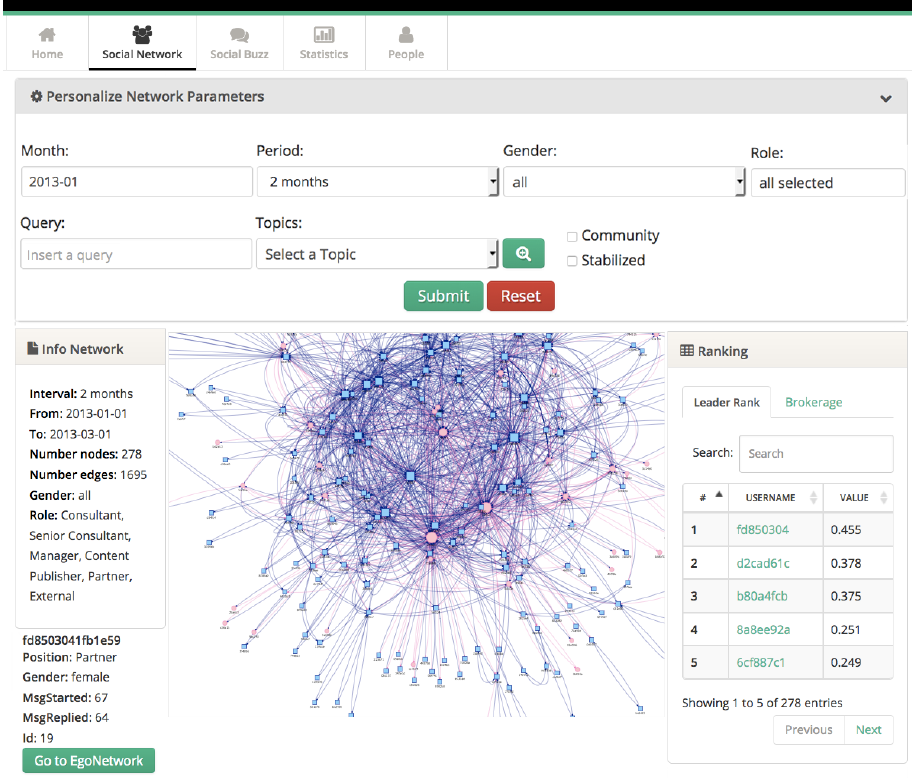
Figure 4. Social network during the first two months of 2013, as shown by our